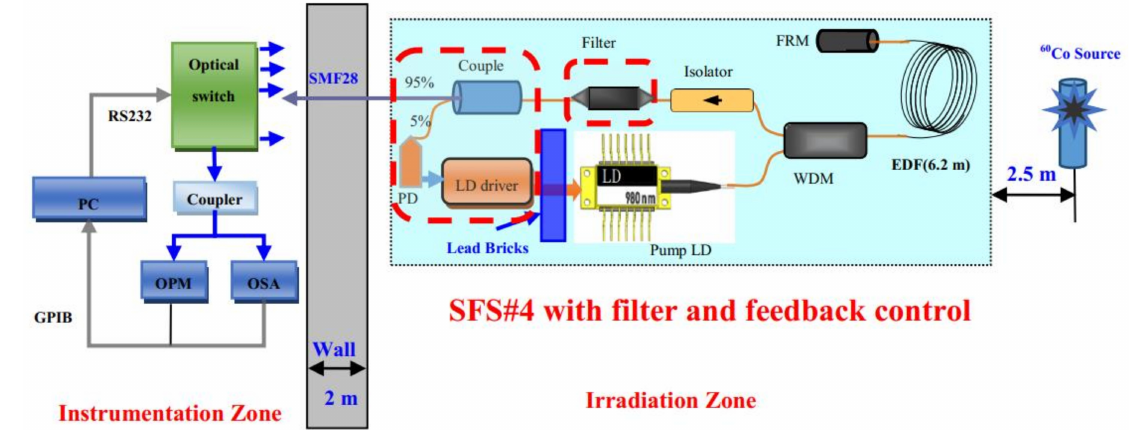
Figure 8. Schematic diagram of the feedback control SFS with the filter under Gamma irradiation. (This SFS is denoted by the symbol